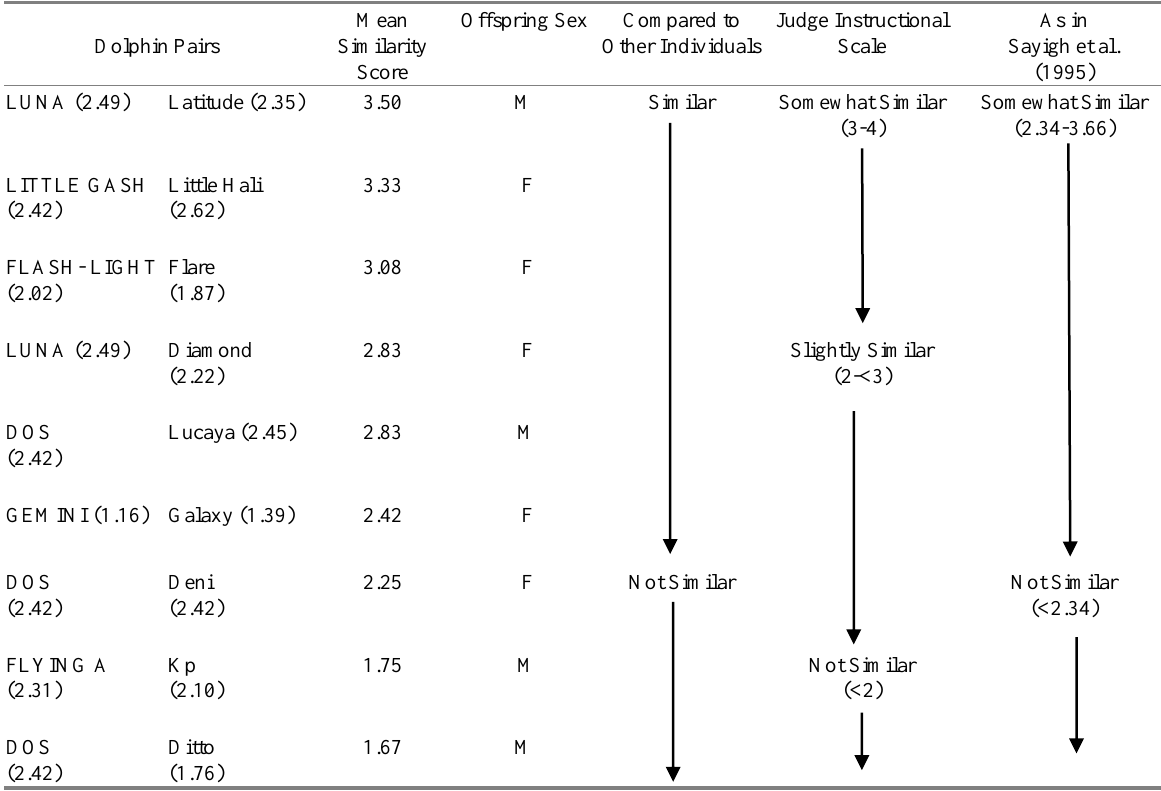
Qualitative Results Presented with three Guidelines of Defining